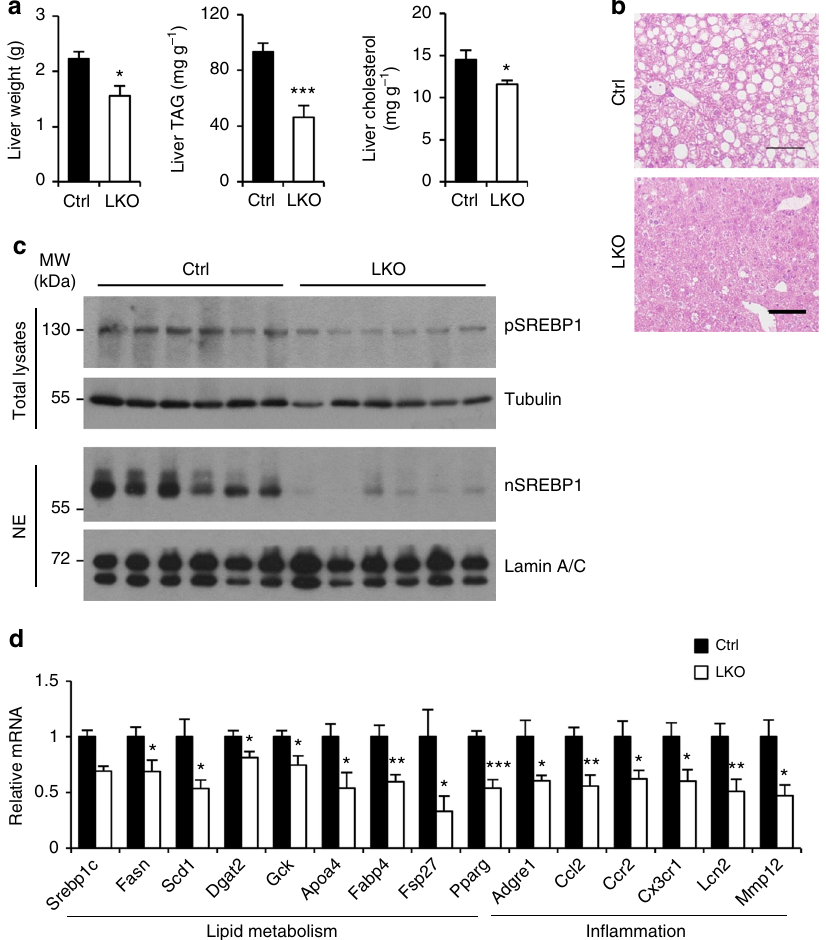
Fig. 4 Liver-speci fi c inactivation of Blnc1 attenuates hepatic lipogenesis and preserves metabolic health. a Liver weight, TAG, and cholesterol content in ctrl ( fi lled, n = 9) and LKO (open, n = 9) mice fed HFD for 19 weeks. b H&E staining of liver sections. Scale bar = 100 μ m. c Immunoblots of total liver lysates and liver nuclear extracts. d qPCR analysis of hepatic gene expression. Data in ( a ) and ( d ) represent mean ± SEM. * p < 0.05, ** p < 0.01, *** p < 0.001; ctrl vs. LKO, two-tailed unpaired Student ’ s t